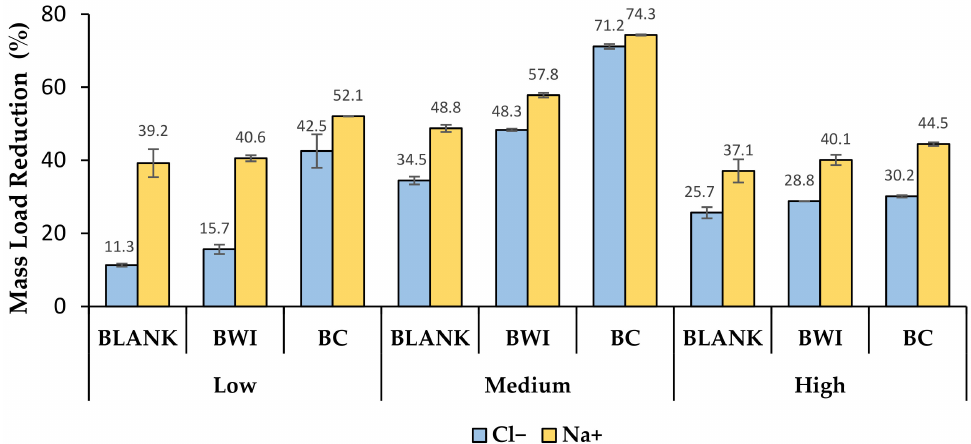
Figure 9. Mass load reduction for different inflow salt concentrations (blank: no plants; BWI: Blue Wild Indigo; BC: Broadleaf